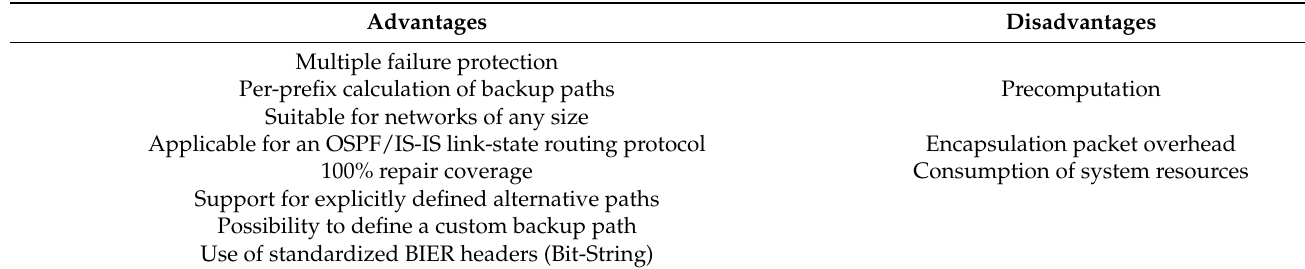
Table 12. Pros and cons of the EB-REP.